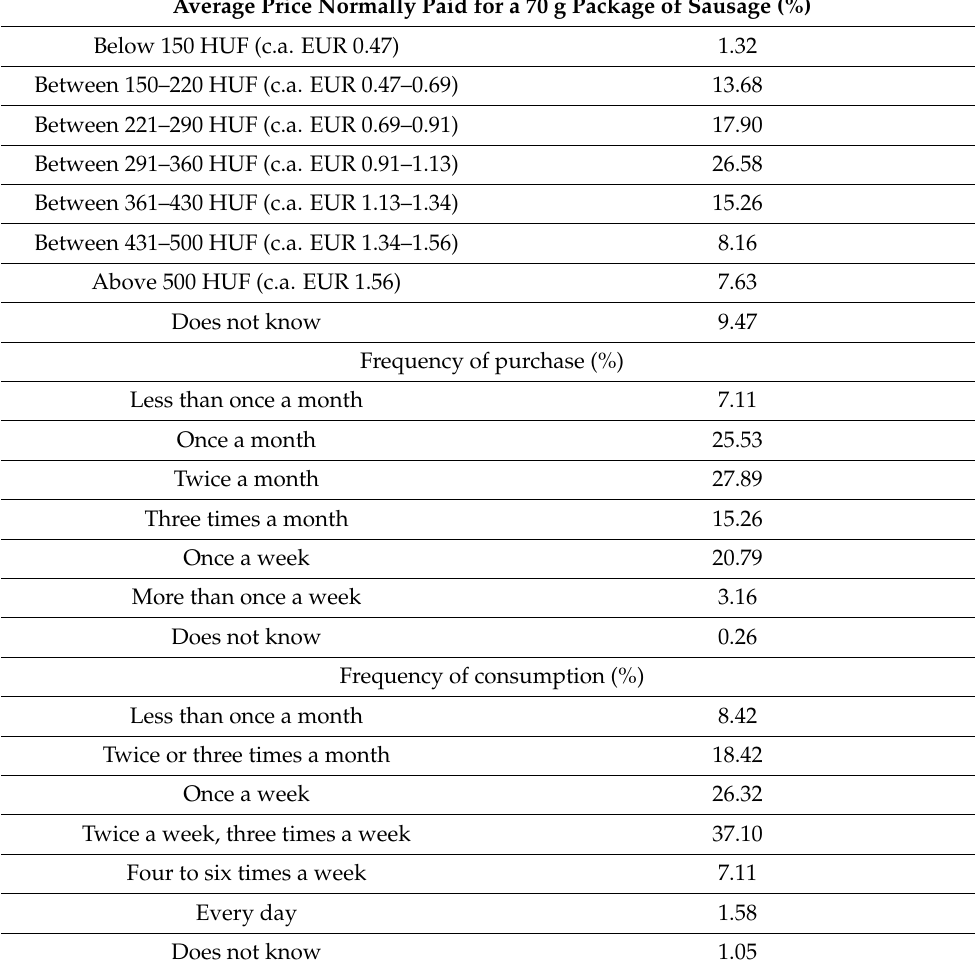
Table 3. Buying and consuming habits of respondents. Average Price Normally Paid for a 70 g Package of Sausage (%) Below 150 HUF (c.a. EUR 0.47) 1.32 Between 150–220 HUF (c.a. EUR